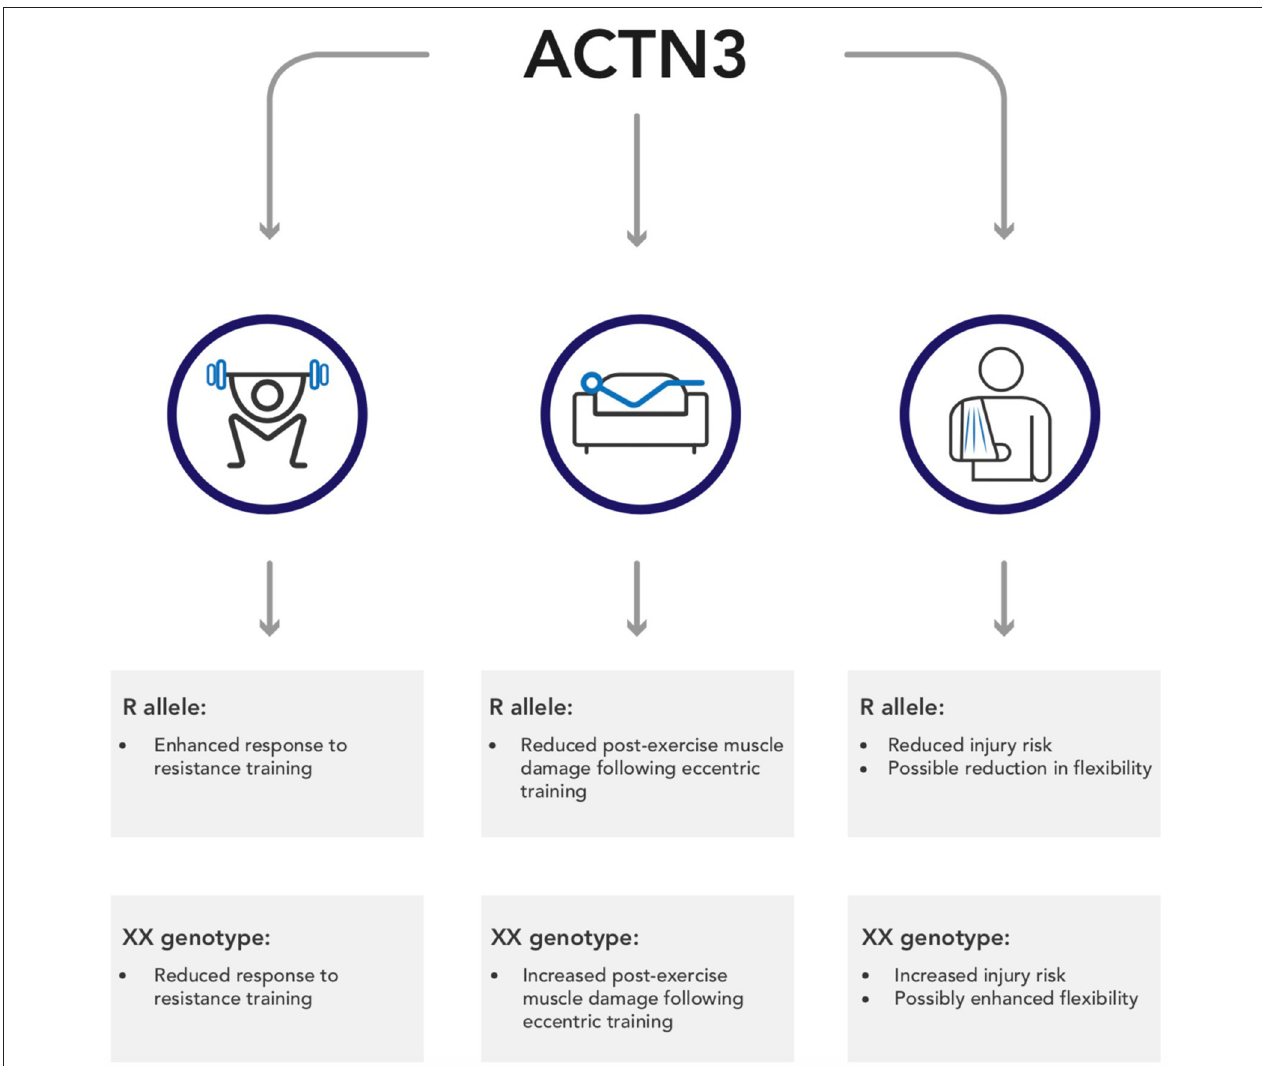
FIGURE 1 | A summary of the potential wider implications of ACTN3 genotype on outcomes from exercise.